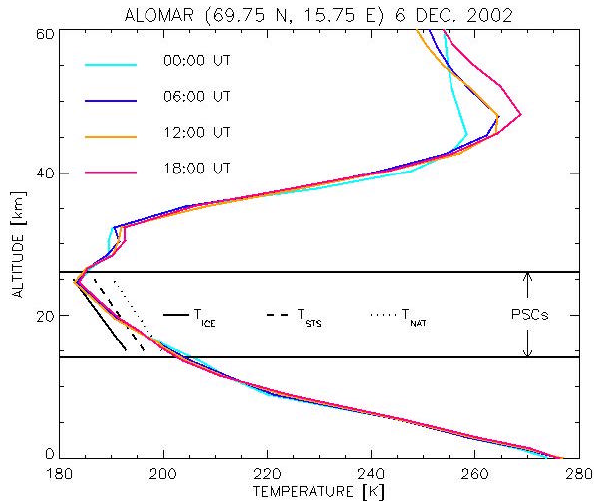
Figure 5. Temperature height profiles from the European Centre for Medium Range Weather Forecast (ECMWF). The location is Andenes on Andøya, Norway (69.75N, 15.75E). Date is 06.12.2002. The profiles are colour coded according to a 6 hour sample period. Also shown are the height region where PSCs are formed together with the 5 ppmv H 2 O threshold temperatures for NAT (dotted line), STS (dashed line) and ice (solid line).